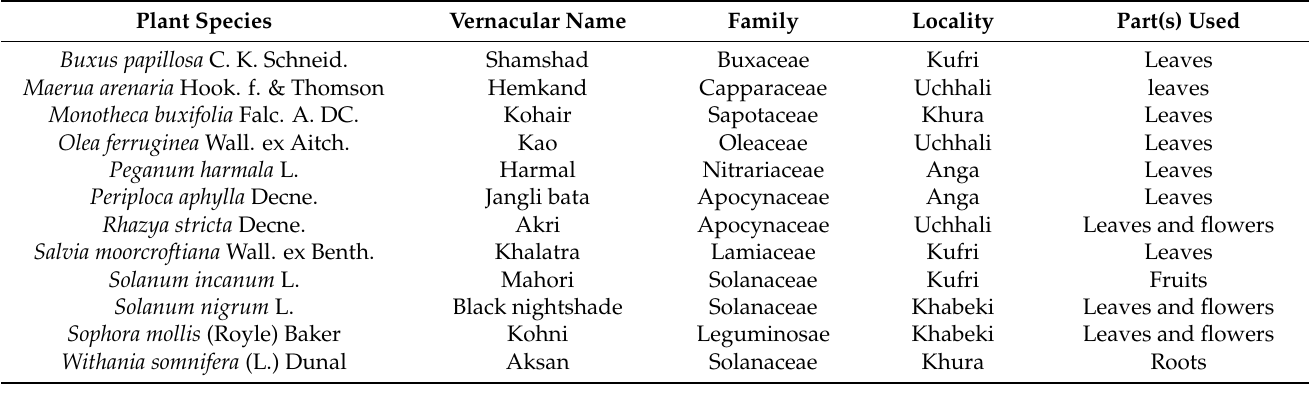
Table 1. Description of plant samples collected from the selected sites of Soone Valley (Khushab) and the surrounding salt range of Pakistan.